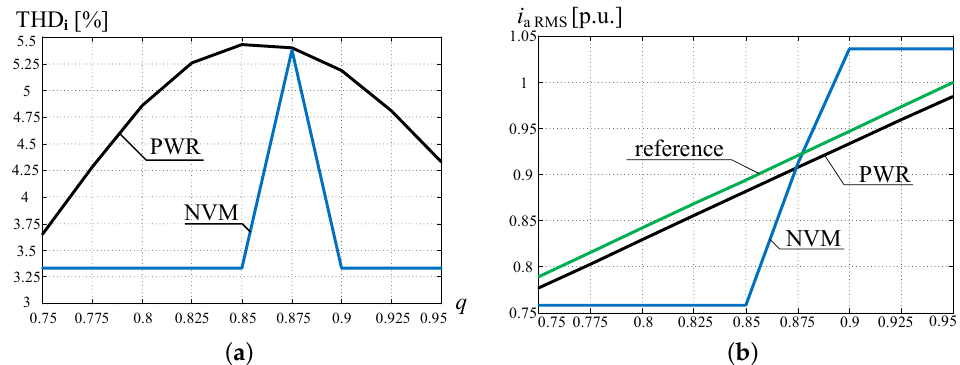
Figure 20. The comparison of the PWR and NVM modulation methods during the inverter operation: ( a ) the load current total harmonic distortion in the applicable range of modulation index, ( b ) the load current RMS value comparison of reference and proposed